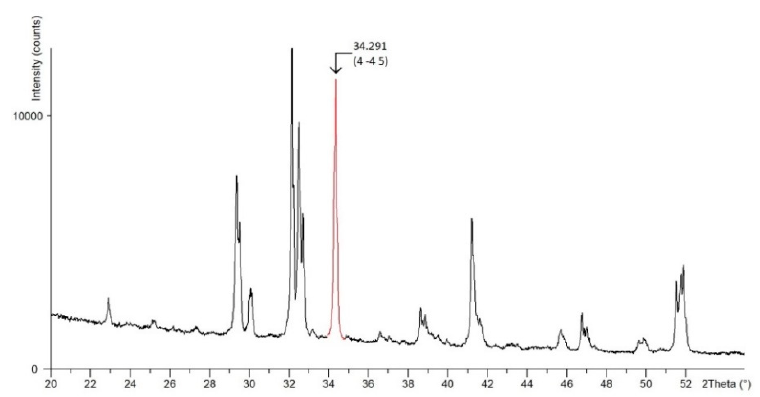
Figure 4. Detail of selected crystallographic plane 44(cid:3364)5 on X-ray pattern.